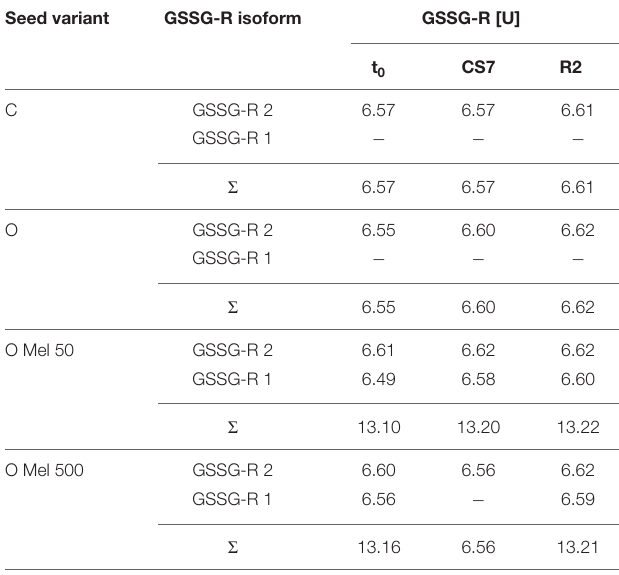
TABLE 2 | GSSG-R isoform activities estimated by densitometric analysis of the native gels (QuantityOne – BioRad). Seed